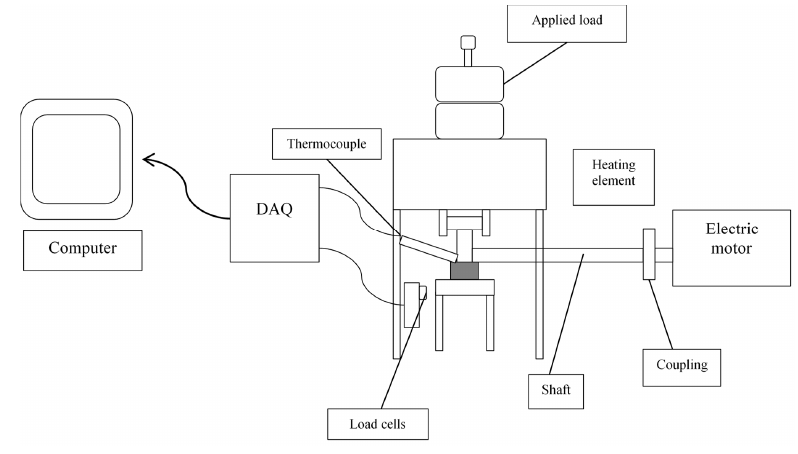
Figure 1. Schematic diagram of tribological testing.